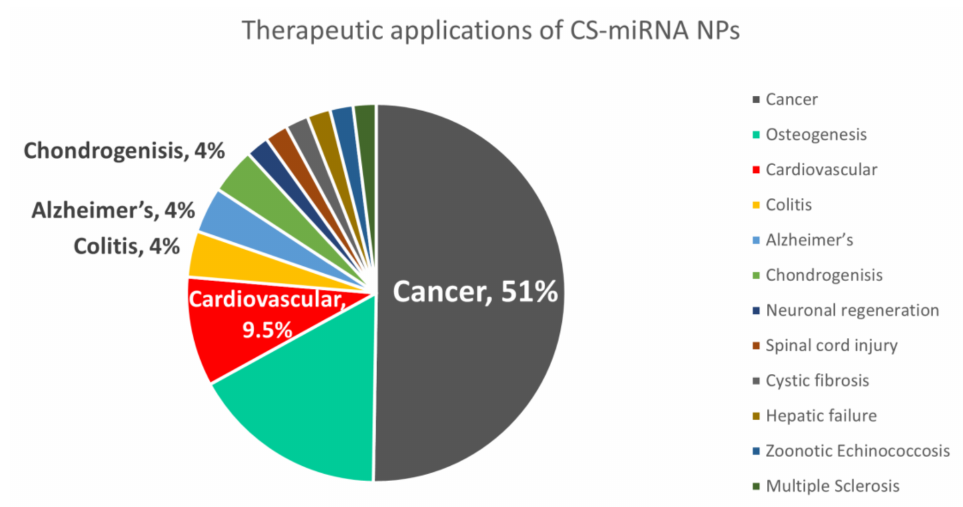
Figure 10. The percent of research focus on different therapeutic applications using chitosan miRNA NPs (out of 53 papers on topic from 2012 to 2022, covered in Table